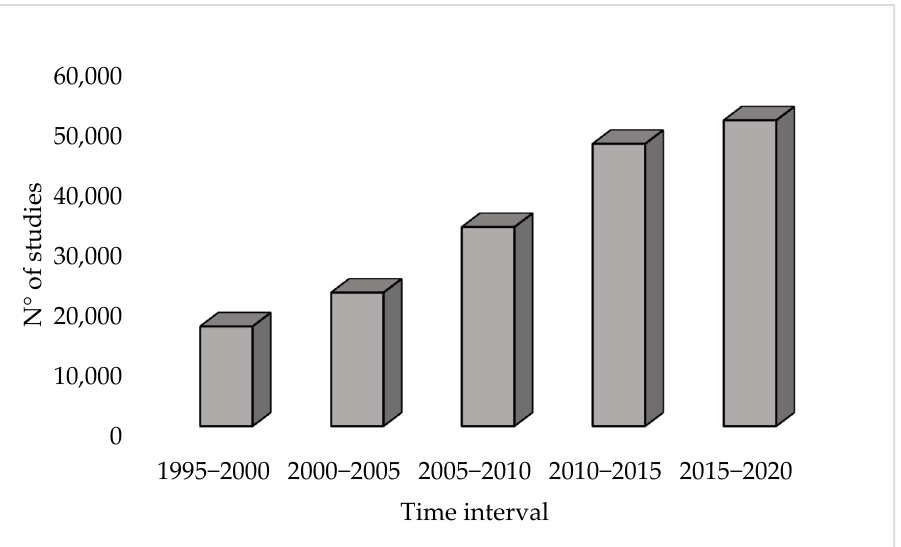
Figure 1. Trend of indexed papers containing the word “composting” from 1995 to 2020 (source of data: Scopus database, accessed in December